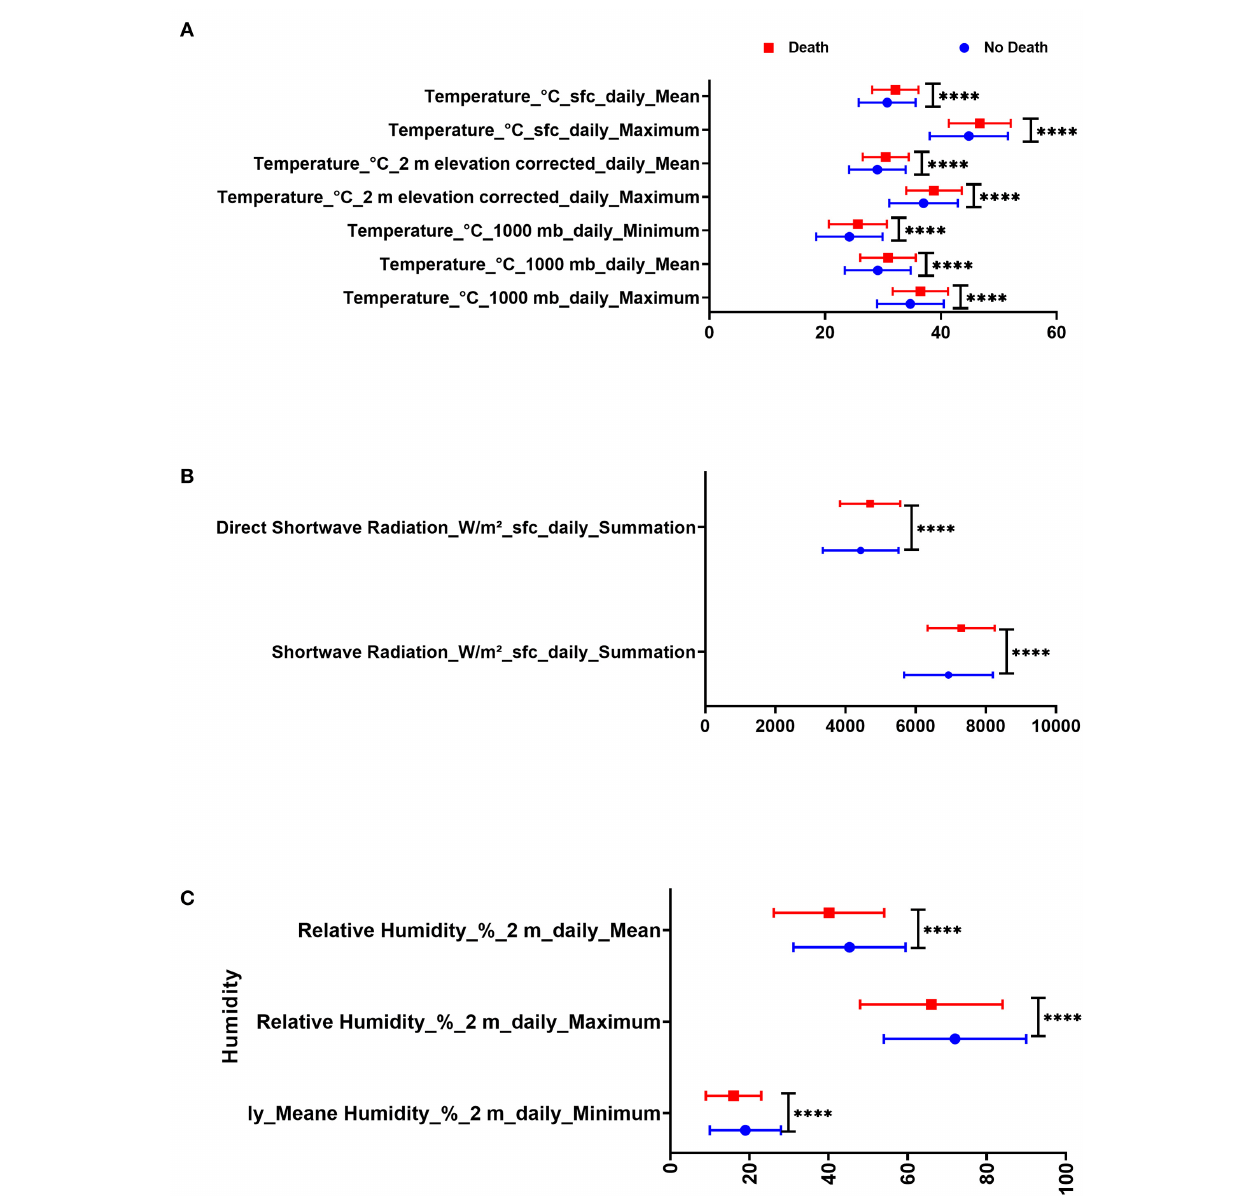
FIGURE 1 | Difference in day admission weather variables in Dubai City between COVID-19 patients with death and those who were discharged in terms of (A) temperature, (B) humidity, and (C) radiation.